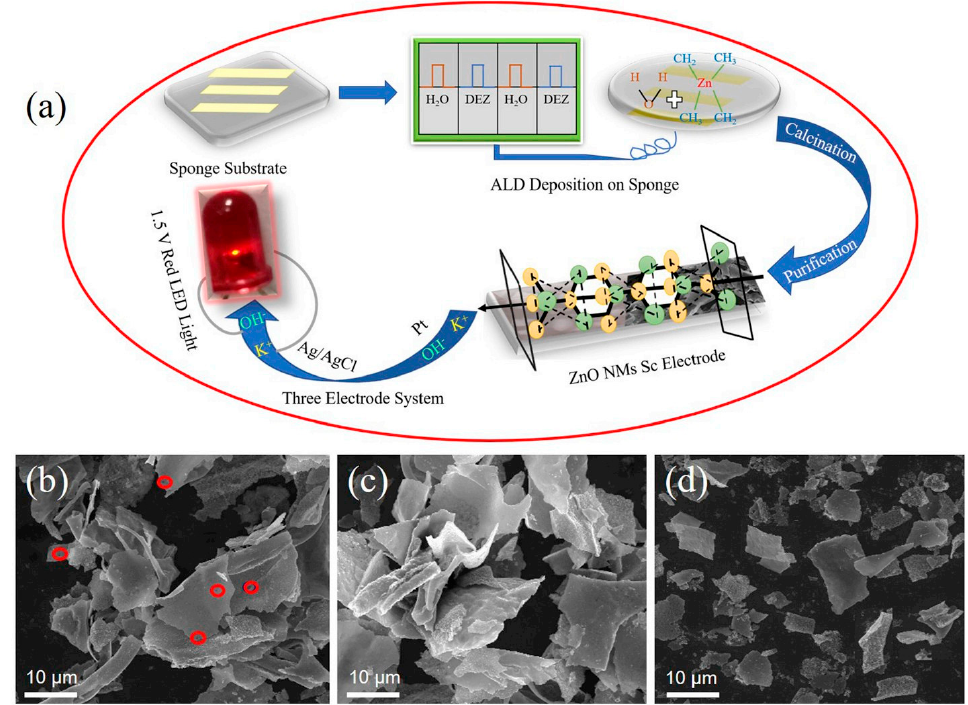
Figure 6. Design and morphologies of ZnO nanomembranes (NMs) with various thicknesses: ( a ) schematic of the fabrication procedure of ZnO NMs electrode and corresponding supercapacitor; ( b – d ) SEM images of ZnO NMs with ( b ) 50, ( c ) 100, and ( d ) 200 atomic layer deposition (ALD) cycles. The red circles in ( b ) represent the existence of the holes in ZnO NMs. Reproduced with permission from [134]. Copyright 2020 Elsevier.